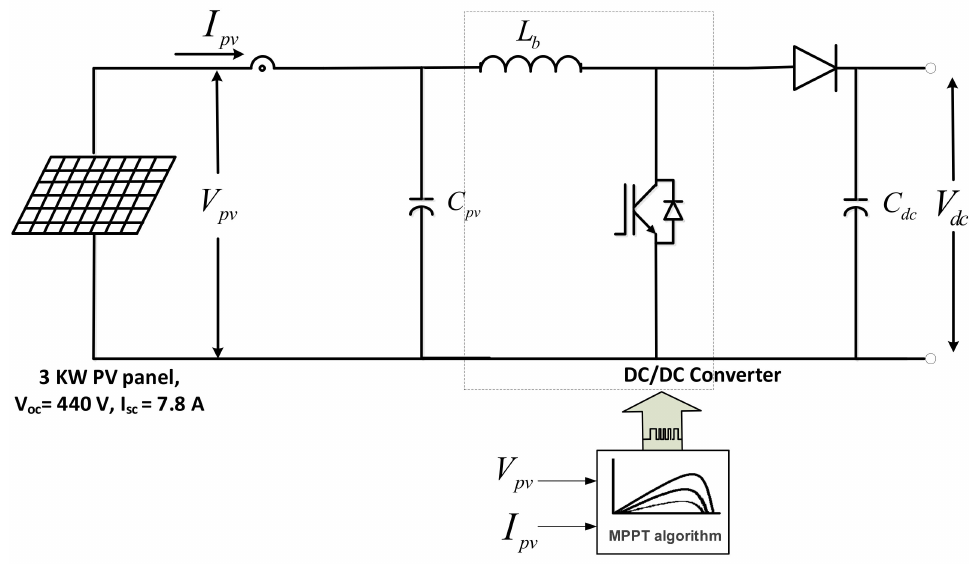
Figure 2. PV Array with DC/DC converter for maximum power